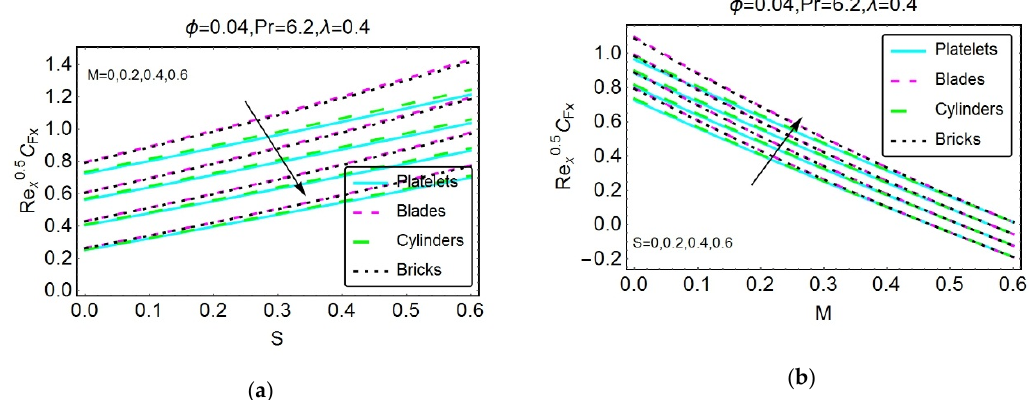
Figure 7. The variations in the skin friction coefficient for different values of ( a ) M and ( b ) S.